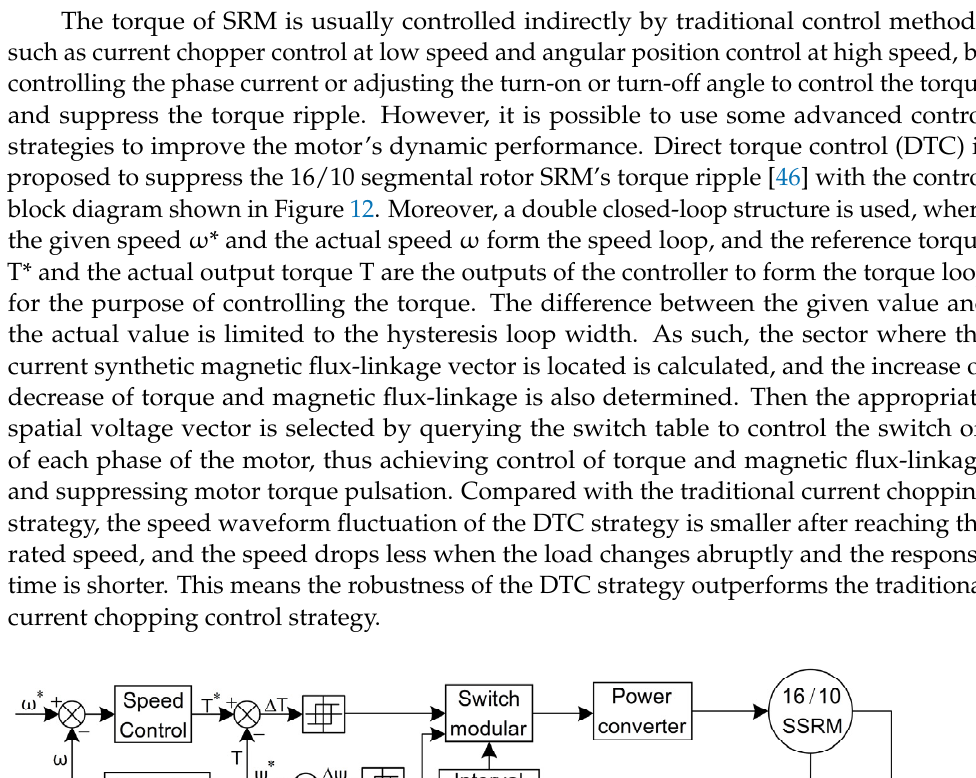
Figure 12. Control block diagram of the DTC system of 16/10 SSRM. Notes: ψ is given flux; ψ * is the actual flux.